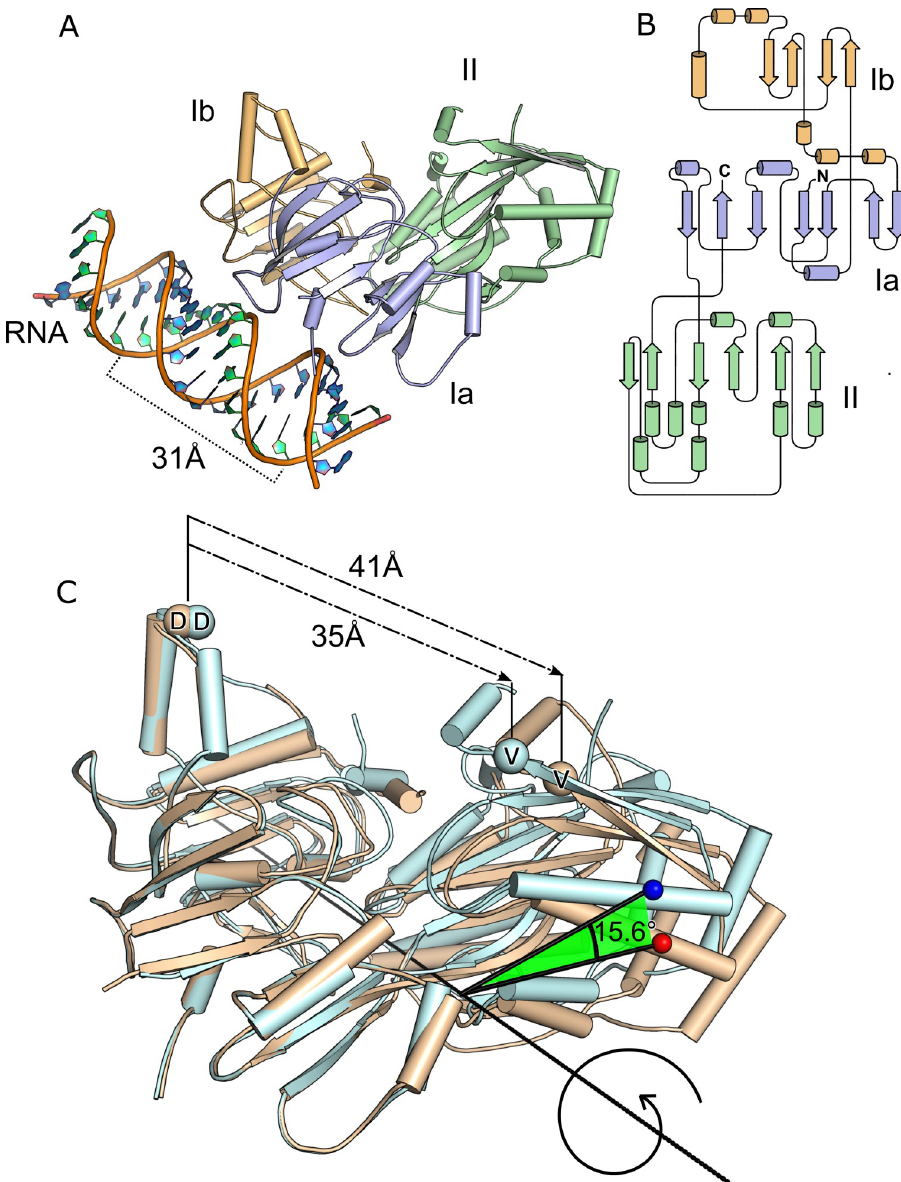
Fig 1. Overall SapA structure. A, the overall structure of SapA closed coloured by domain. Each SapA monomer was co-crystallised with a single-stranded A-form RNA molecule. The antisense strand (turquoise rings) completing the duplex is contributed by a symmetry mate SapA closed molecule not shown in the diagram. The pitch distance of the RNA helix is indicated. B, topology diagram of SapA. C, comparison of the closed (light cyan) and open (wheat) conformations of SapA. Rotation angle around axis was calculated and visualised with the program ProSMART . The distances between the C α atoms of residues Asp 222 and Valine 435 are indicated in the closed and open